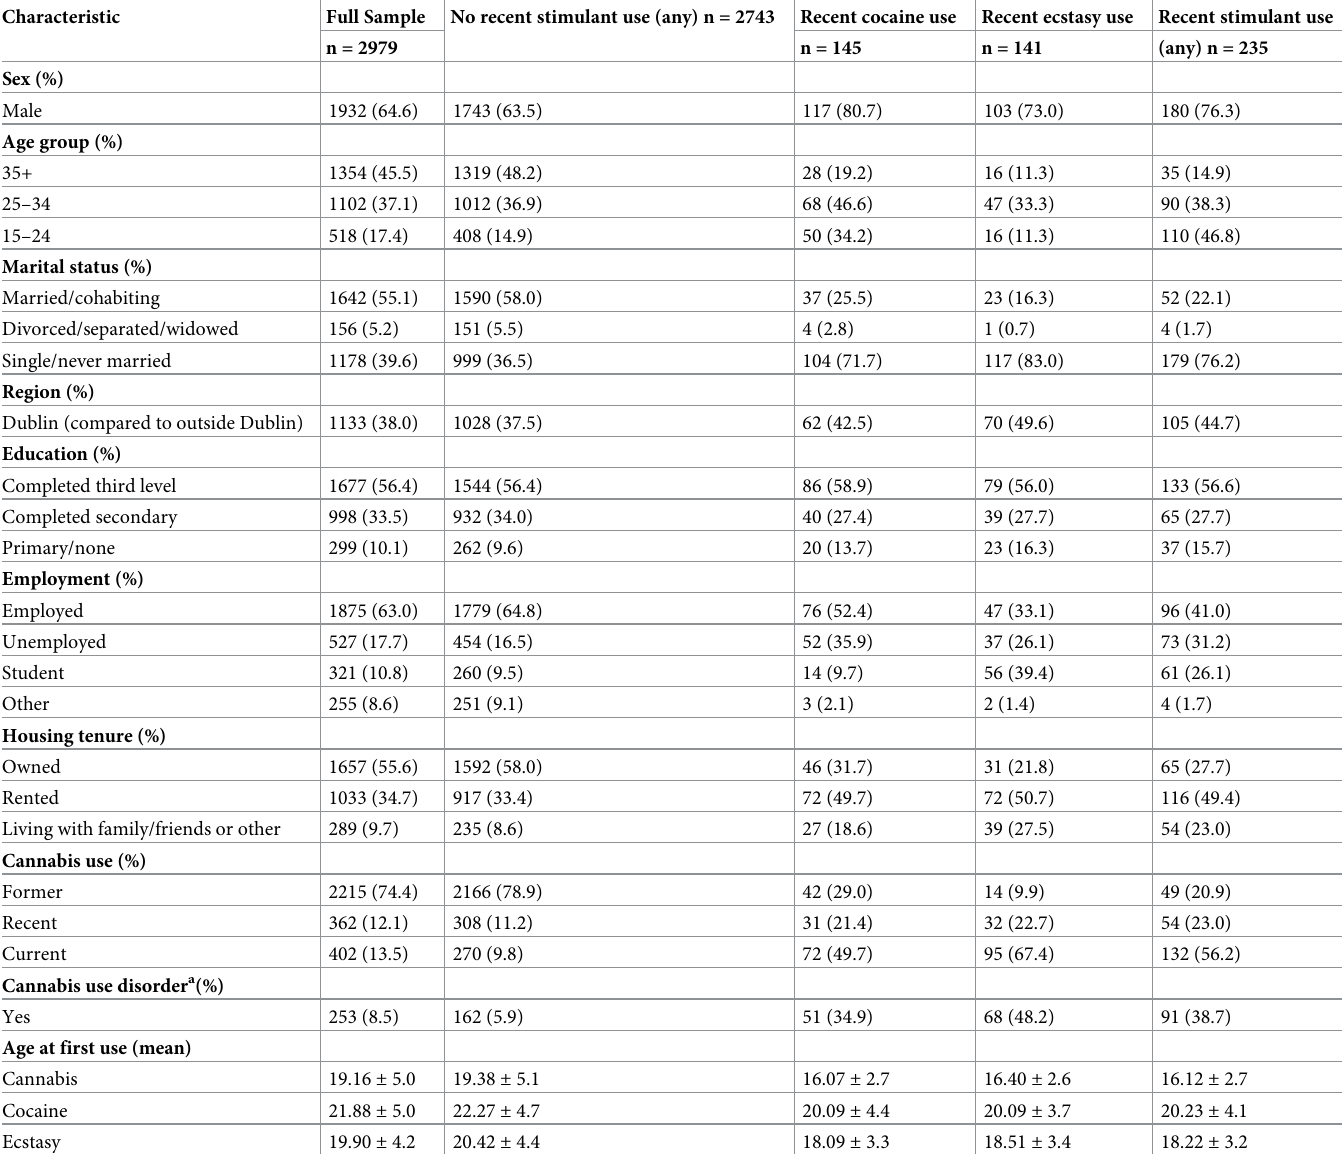
Table 1. Characteristics of cannabis users–full sample and according to recent stimulant use.